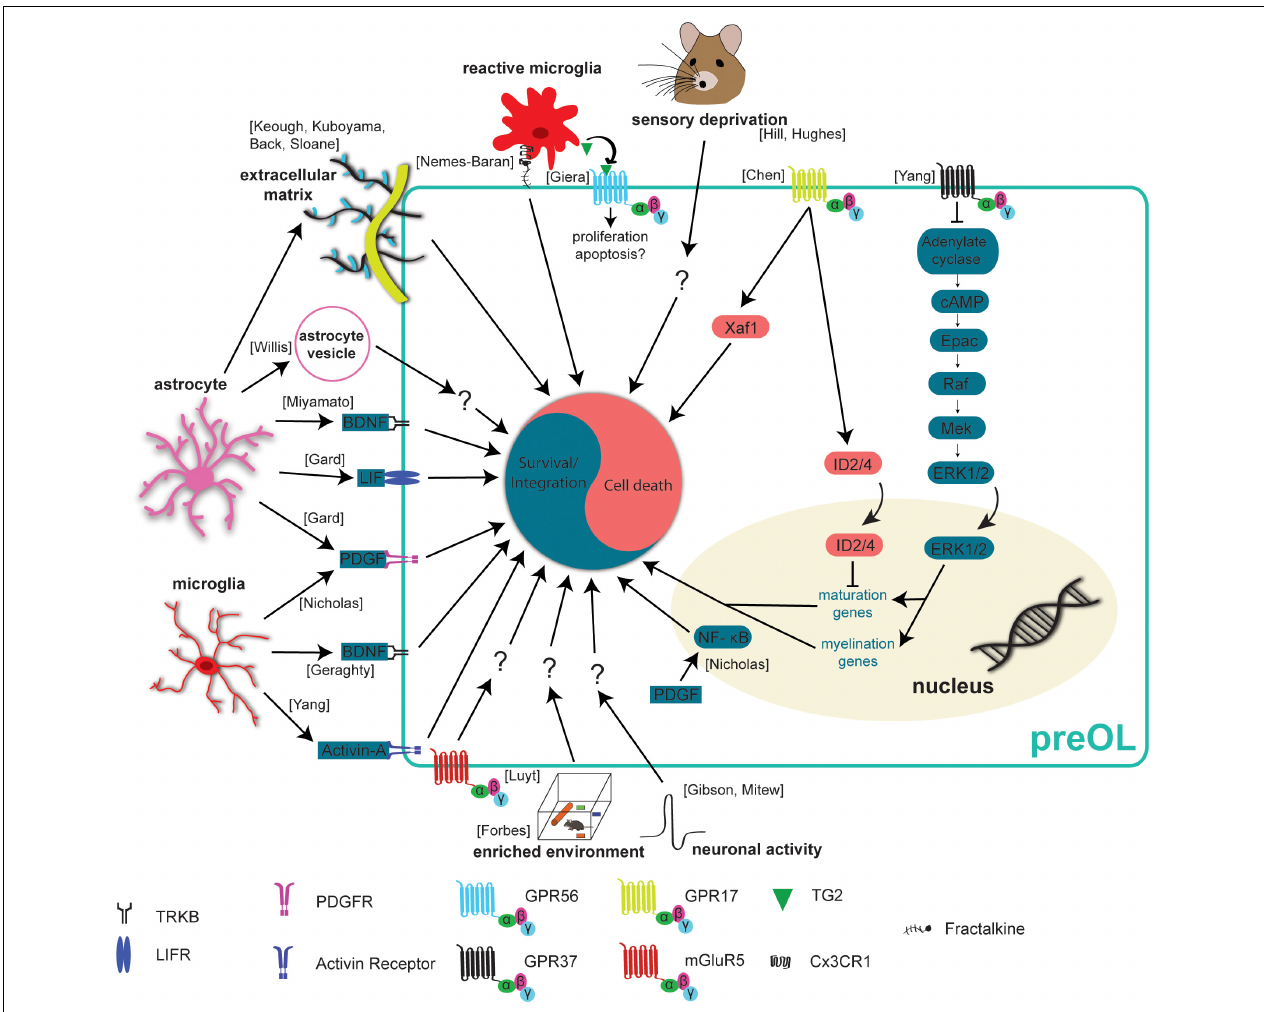
FIGURE 3 | Extrinsic mechanisms regulating preOL survival and integration. Premyelinating oligodendrocytes are responsive to extrinsic signals in their local environment. This means that neurons, microglia, and astrocytes all influence preOLs, in some cases to promote survival and integration (blue) and in others to promote cell death (red). Neuronal activity has been found to increase the production of new oligodendrocytes (Gibson et al., 2014; Mitew et al., 2018). Exposure to enriched environments promotes the production and maturation of new oligodendrocytes after hypoxic injury (Forbes et al., 2020). Sensory deprivation via whisker trimming reduces the production of new oligodendrocytes (Hill et al., 2014; Hughes et al., 2018). Microglial derived factors like Activin-A, PDGF, and BDNF promote survival and integration (Nicholas et al., 2001; Miron et al., 2013; Geraghty et al., 2019). Astrocyte derived factors BDNF, LIF, and PDGF also promote survival and integration (Gard et al., 1995; Miyamoto et al., 2015). PDGF upregulates NF- κ B to reduce apoptosis and enhance maturation (Nicholas et al., 2001). The presence of extracellular vesicles from young astrocytes results in more efficient differentiation and maturation of primary OPC cultures (Willis et al., 2020). Activation